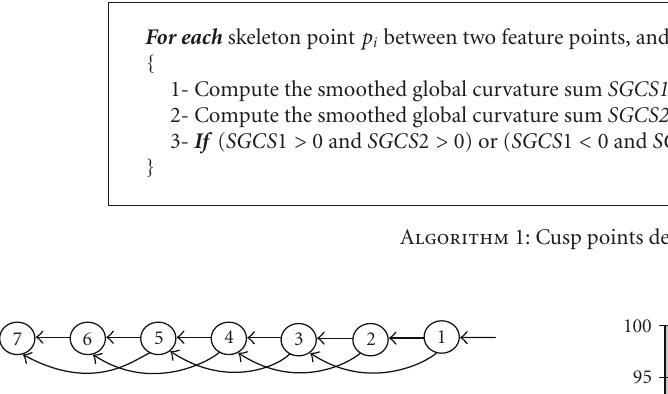
Figure 6: A right-to-left HMM with explicit state duration and interstate skips for the word “